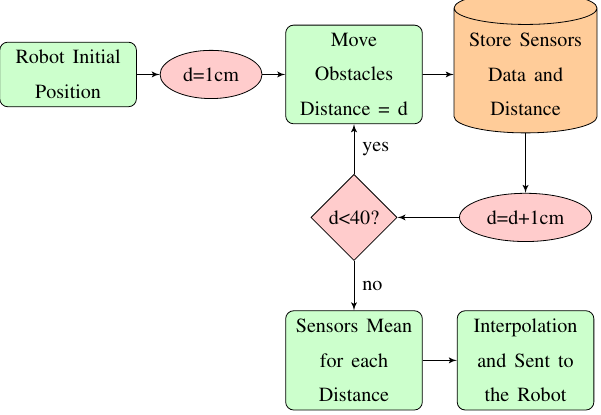
Figure 4. Robot 1 and 2 IR sensors values vs. distance Figure 3. Flow diagram of the traditional calibration procedure.